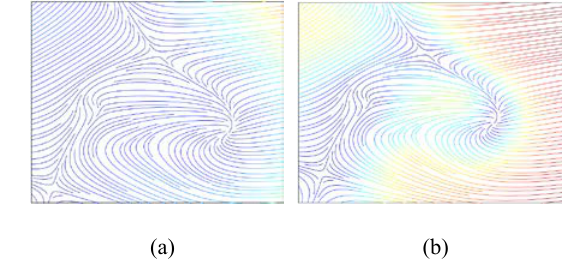
Fig. 6. Comparison of streamline color mapping